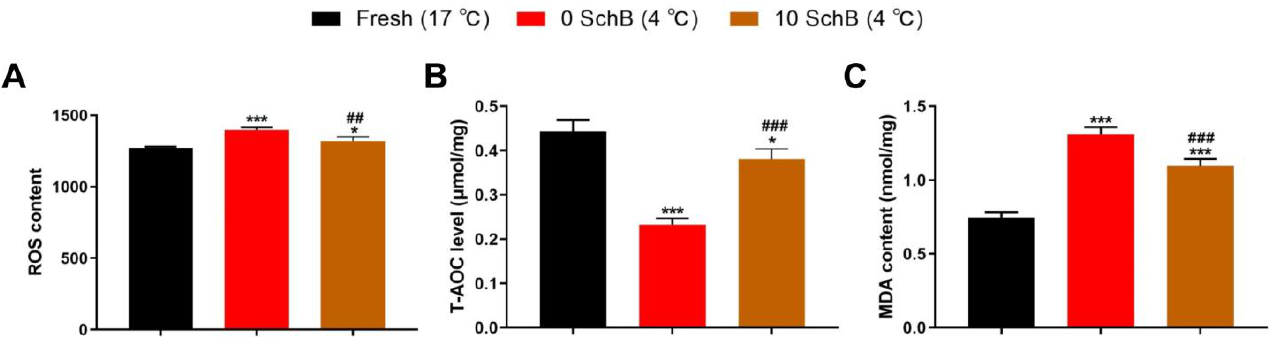
Figure 5. Effect of Sch B on boar sperm ROS ( A ), T-AOC ( B ), and MDA level ( C ): Data are expressed as mean ± SD ( n = 12). ### p < 0.001 and ## p < 0.01 vs. 0 Sch B, *** p < 0.001 and * p < 0.05 vs. fresh.